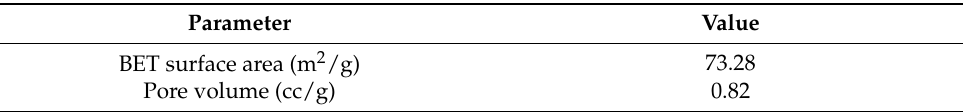
Table 1. Surface area, pore volume and diameter of